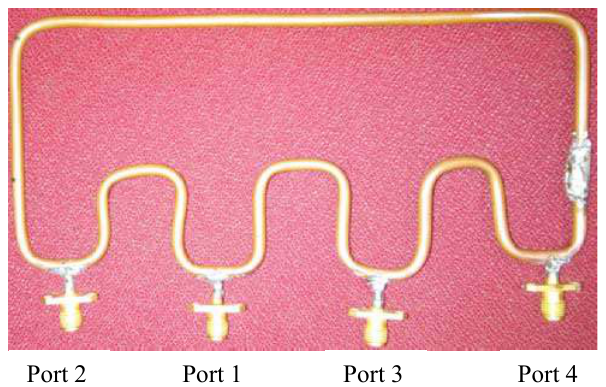
Fig. 5: Simulation model of micro strip ring Rat-Race